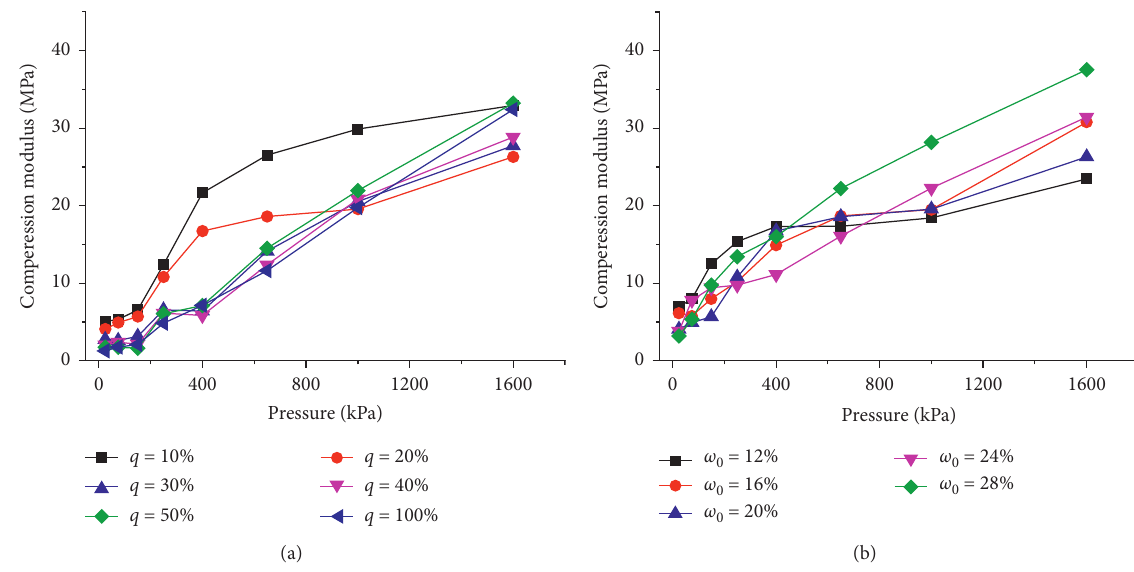
Figure 9: Relationship between compression modulus and grouting pressure. (a) At different clay contents. (b) At different initial water ratios.